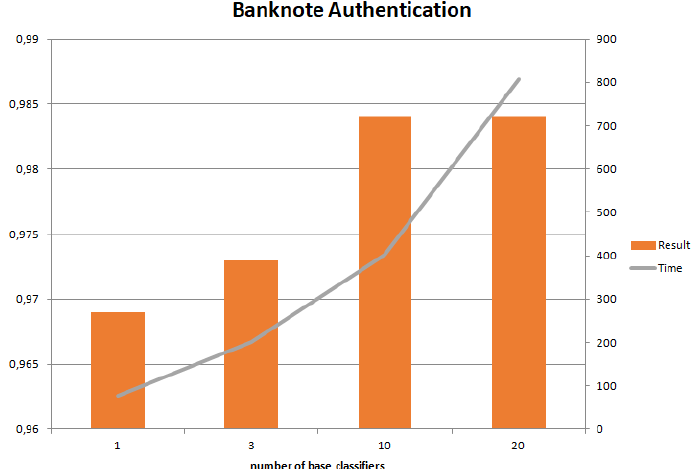
Fig. 5. Number of base classi¯ers in Banknote